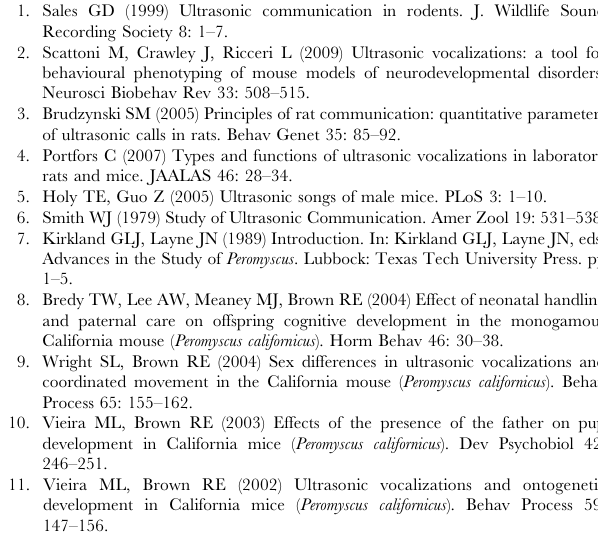
Table S1 Eigenvalues and factor coordinates for variables of PC1 for a) 1 syllable vocalizations, b) 2 syllable vocalizations, and c) 3 syllable vocalizations.